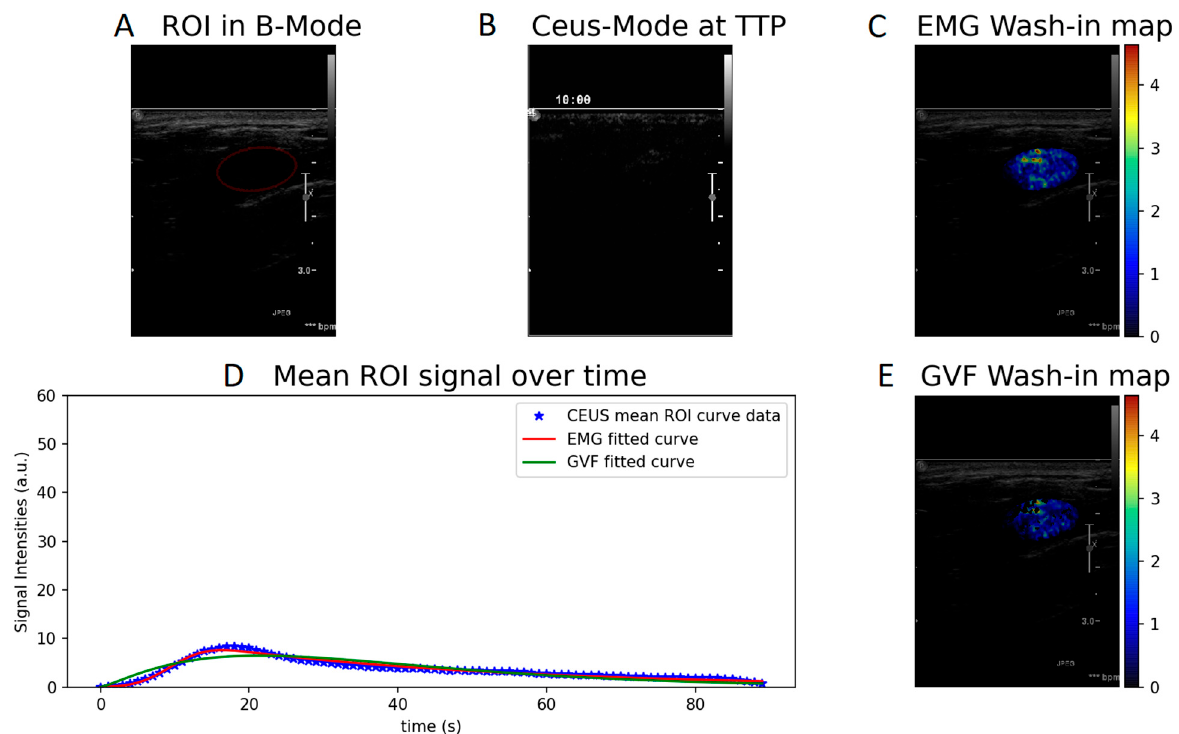
Figure 4. Wash-in parametric map calculated with EMG (C) and GVF (E) of a benign case. (A) ROI in B-mode, (B) CEUS mode at time to peak, and (D) EMG and GVF fitted to the mean ROI signal over time.